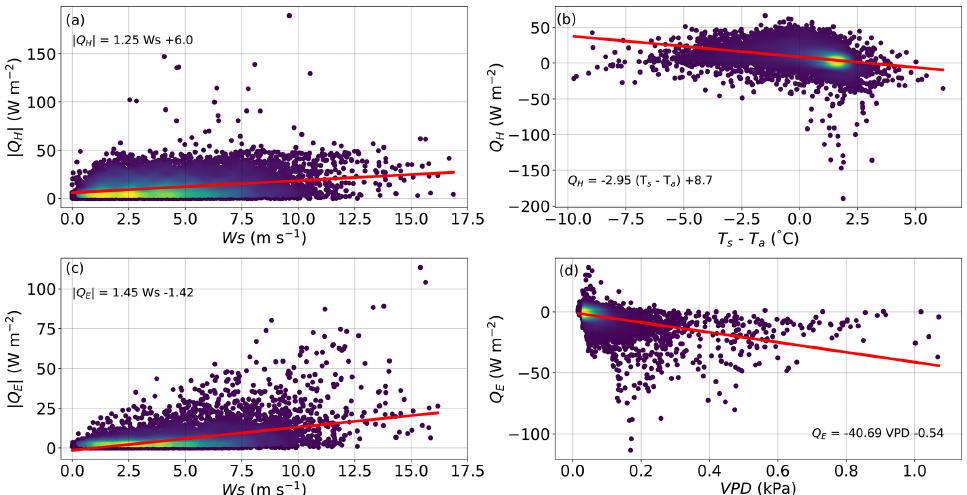
Figure 6. Scatter plot of hourly values of sensible ( Q H , upper row) and latent ( Q E , lower row) heat fluxes against some key meteorological variables: (a, c) wind speed, (b) temperature difference between the air and the snow surface, and (d) vapor pressure deficit. The color code indicates the density of points, where yellow represents high density and blue low density. The red line shows a linear